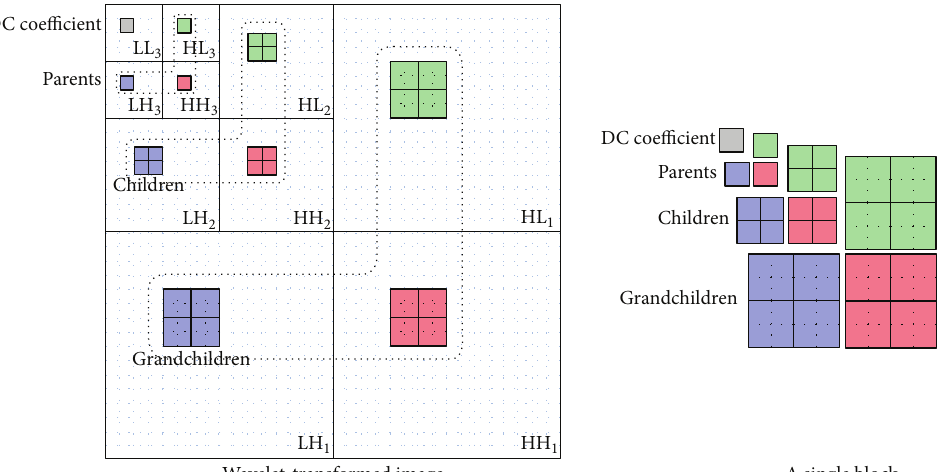
Figure 2: A coefficients block having 64 coefficients from different levels, and the 64 coefficients are all decomposed coefficients of a small adjacent area in original band of multispectral